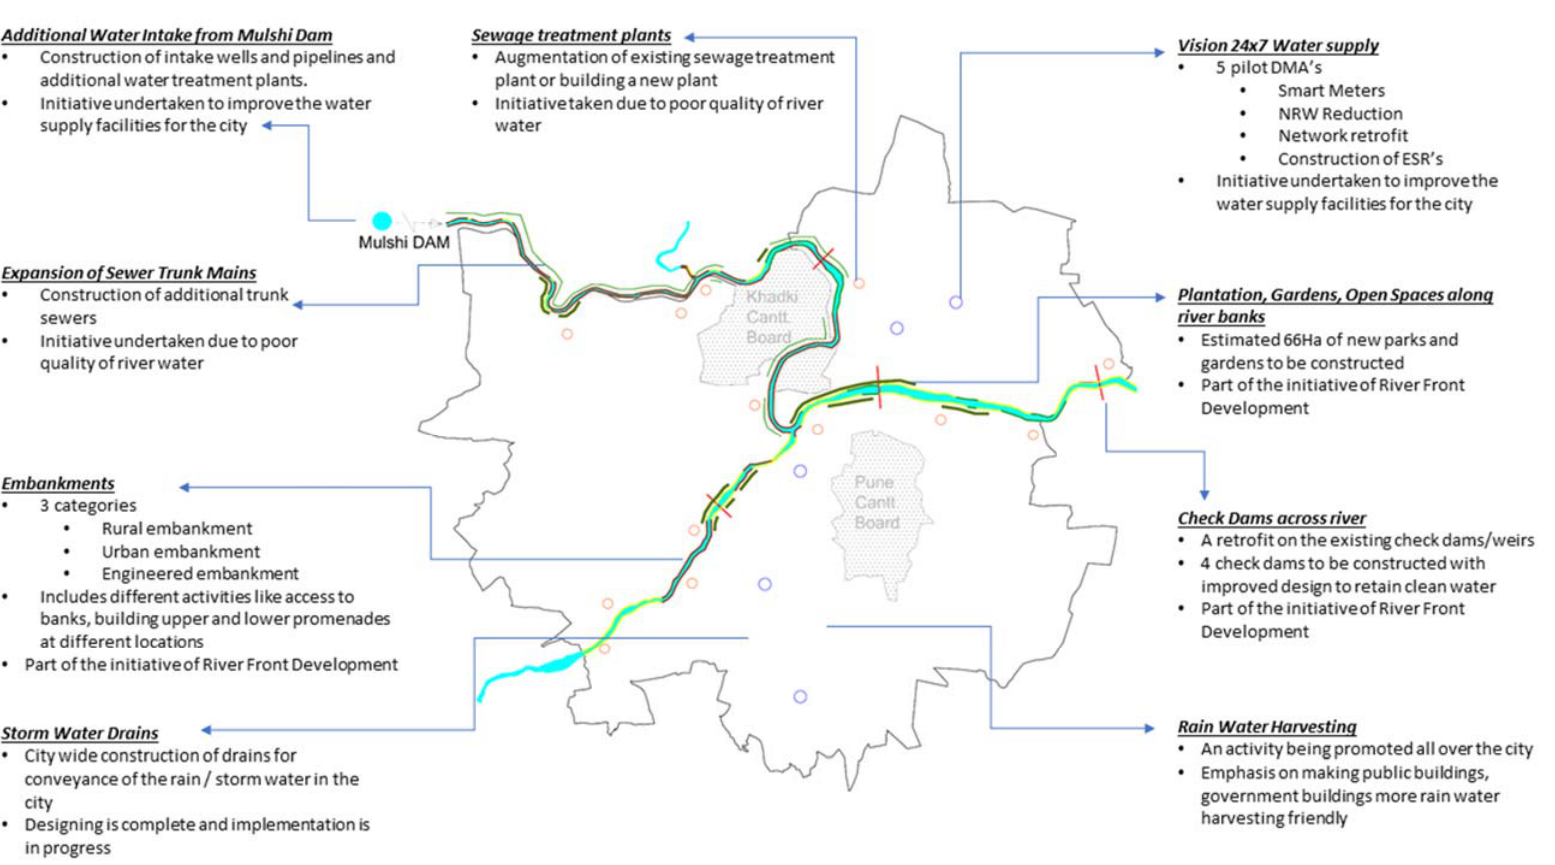
Figure 3. Adaptation responses for Pune, collated from existing planning documents.